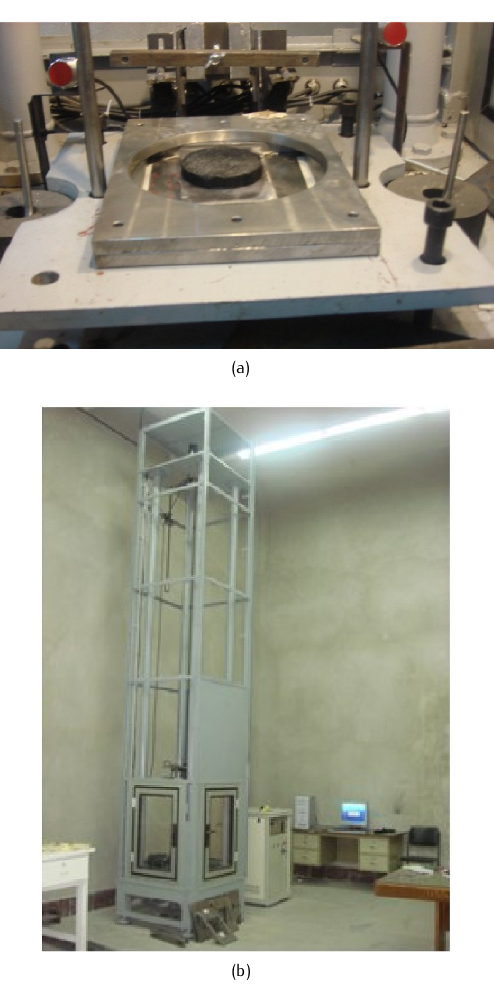
Figure 9. Drop hammer testing machine applied in low-velocity im- pact: (a) view of a specimen in drop hammer machine; (b) general view of drop hammer testing machine.